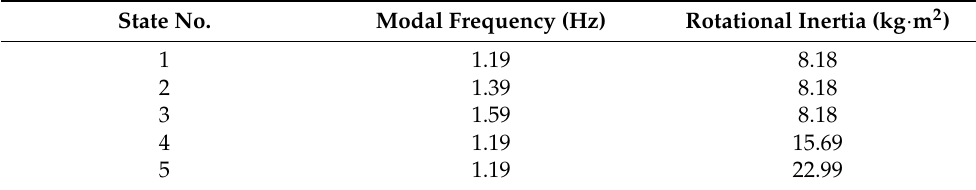
Table 2. List of modal frequencies and rotational inertias from the test in different states. State